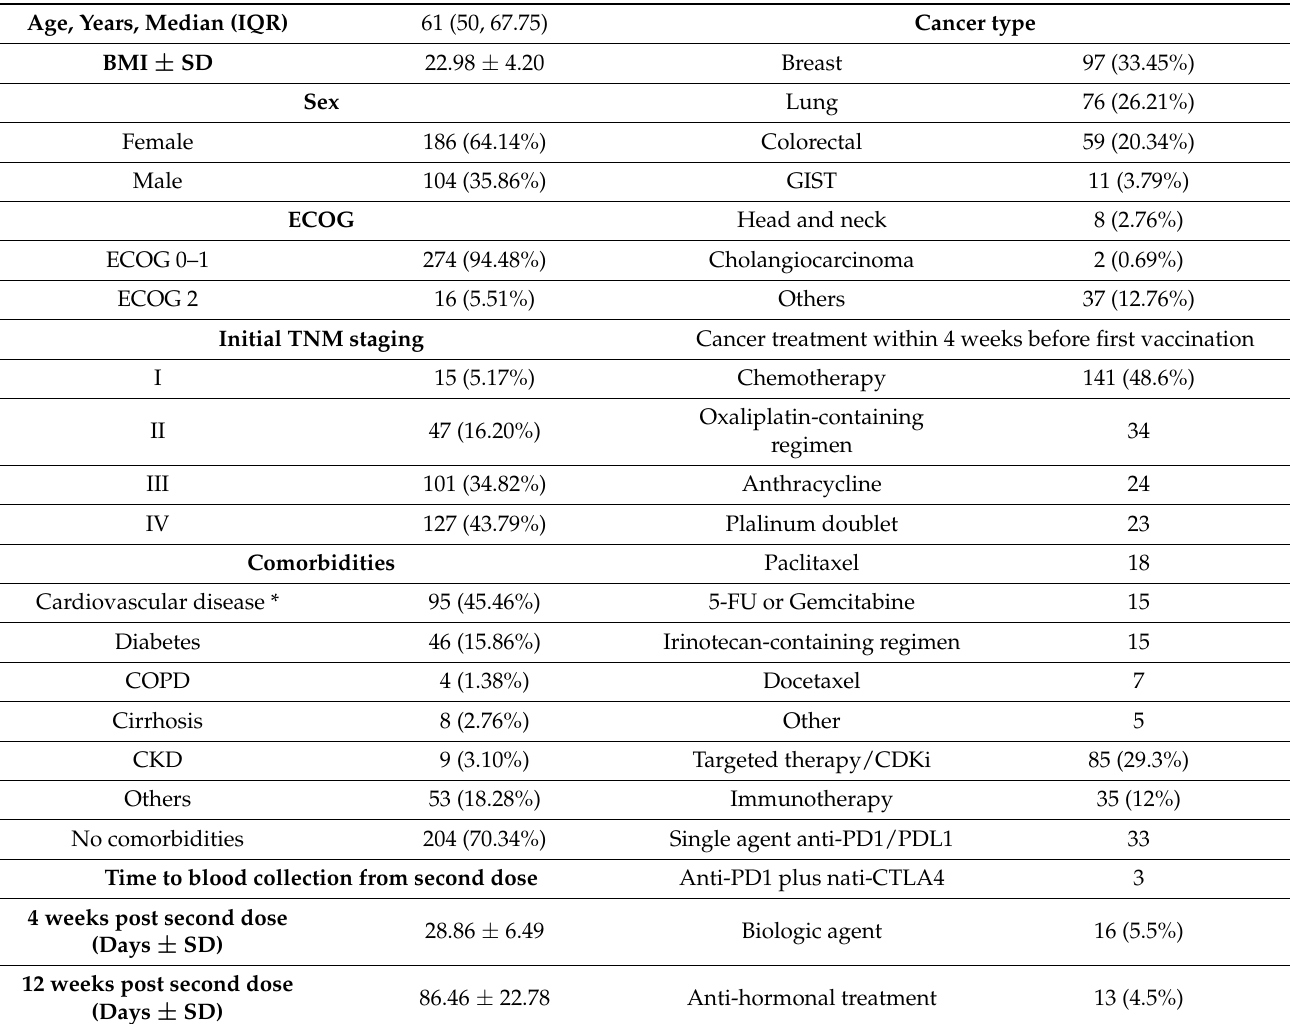
Table 1. Demographic data of 290 oncologic